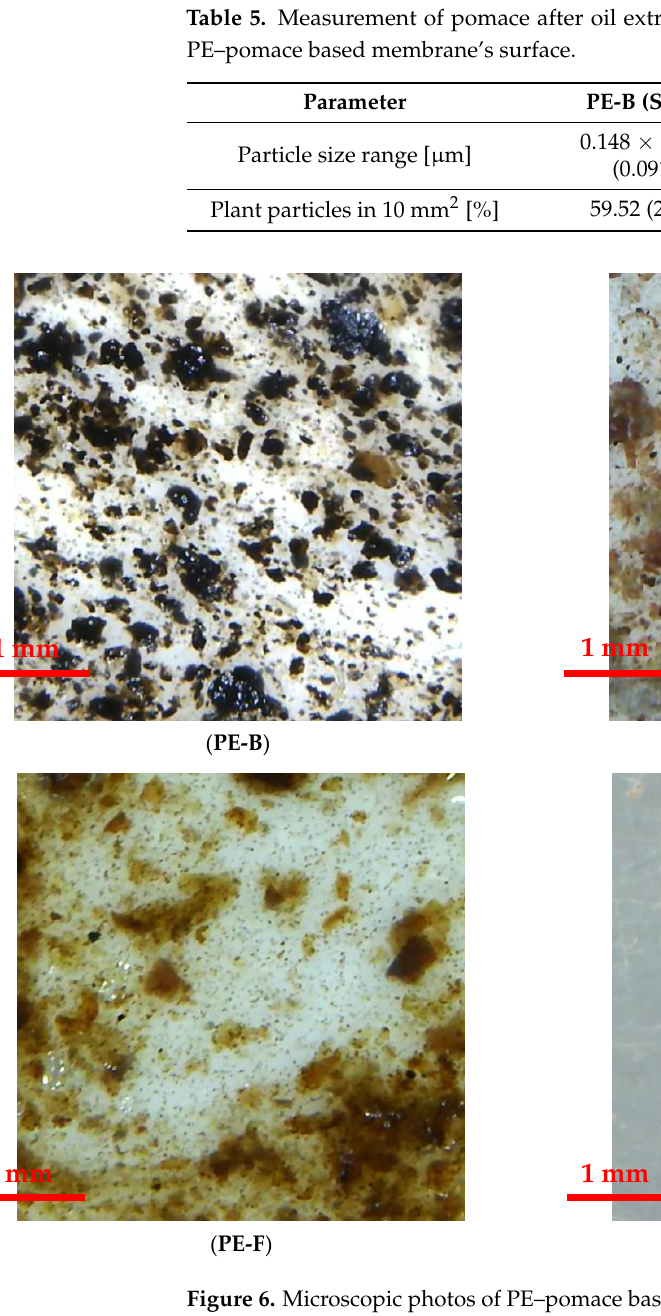
Table 4. Measurement of surface wettability of PE – pomace based membranes.